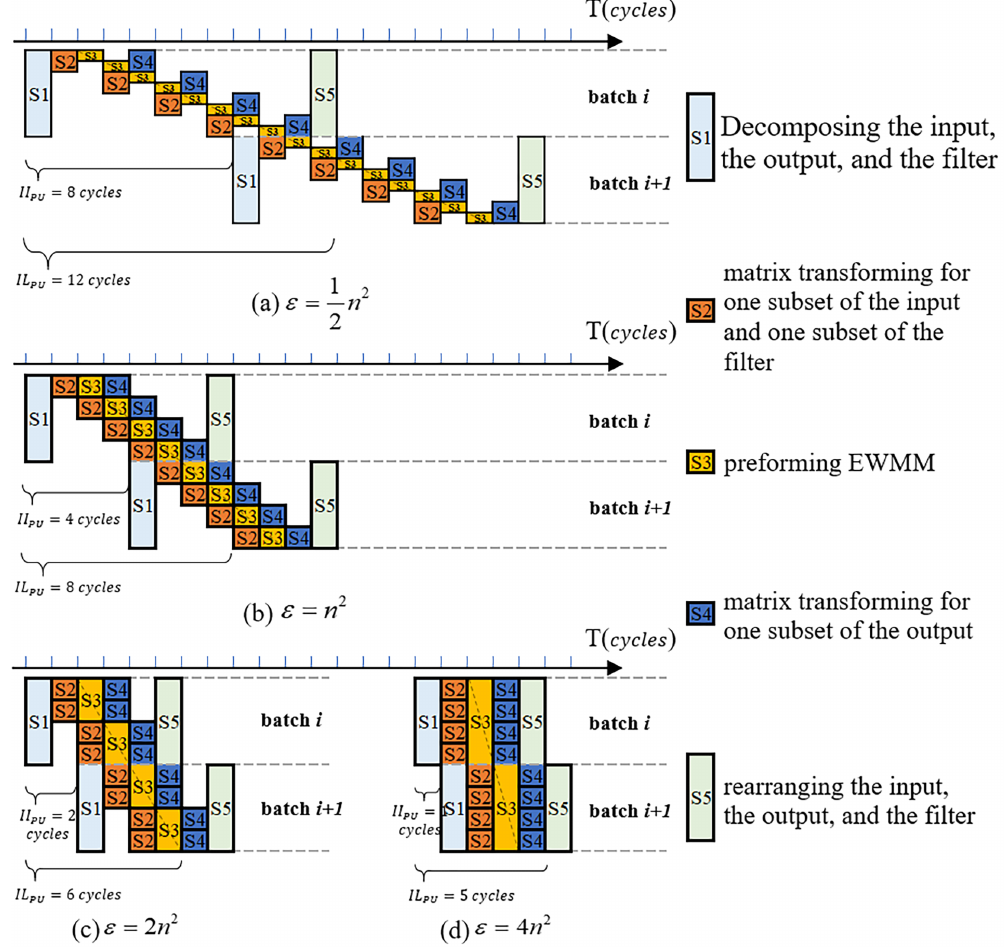
Figure 11. Timing diagrams of four typical parallel implementations for S1–S5 operations in a